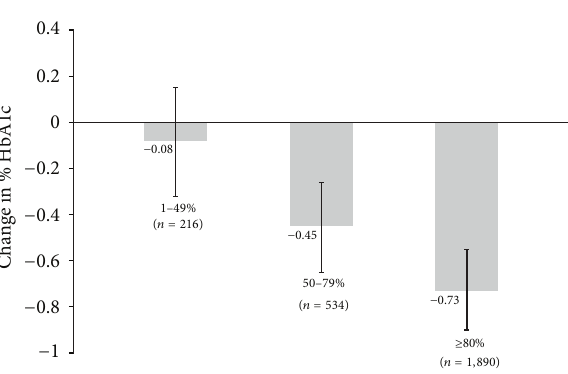
Figure 3: Percentage point change in HbA1c between first HbA1c measured 6–12 months after metformin initiation and last HbA1c of observation period measured 3–21 months later by change in category of Biologic Response Based Proportion of Days Covered where no change is the reference group. Data are for those whose HbA1c measured 6–12 months after metformin initiation was ≥ 7% (Analysis 3). Error bars represent 95% confidence